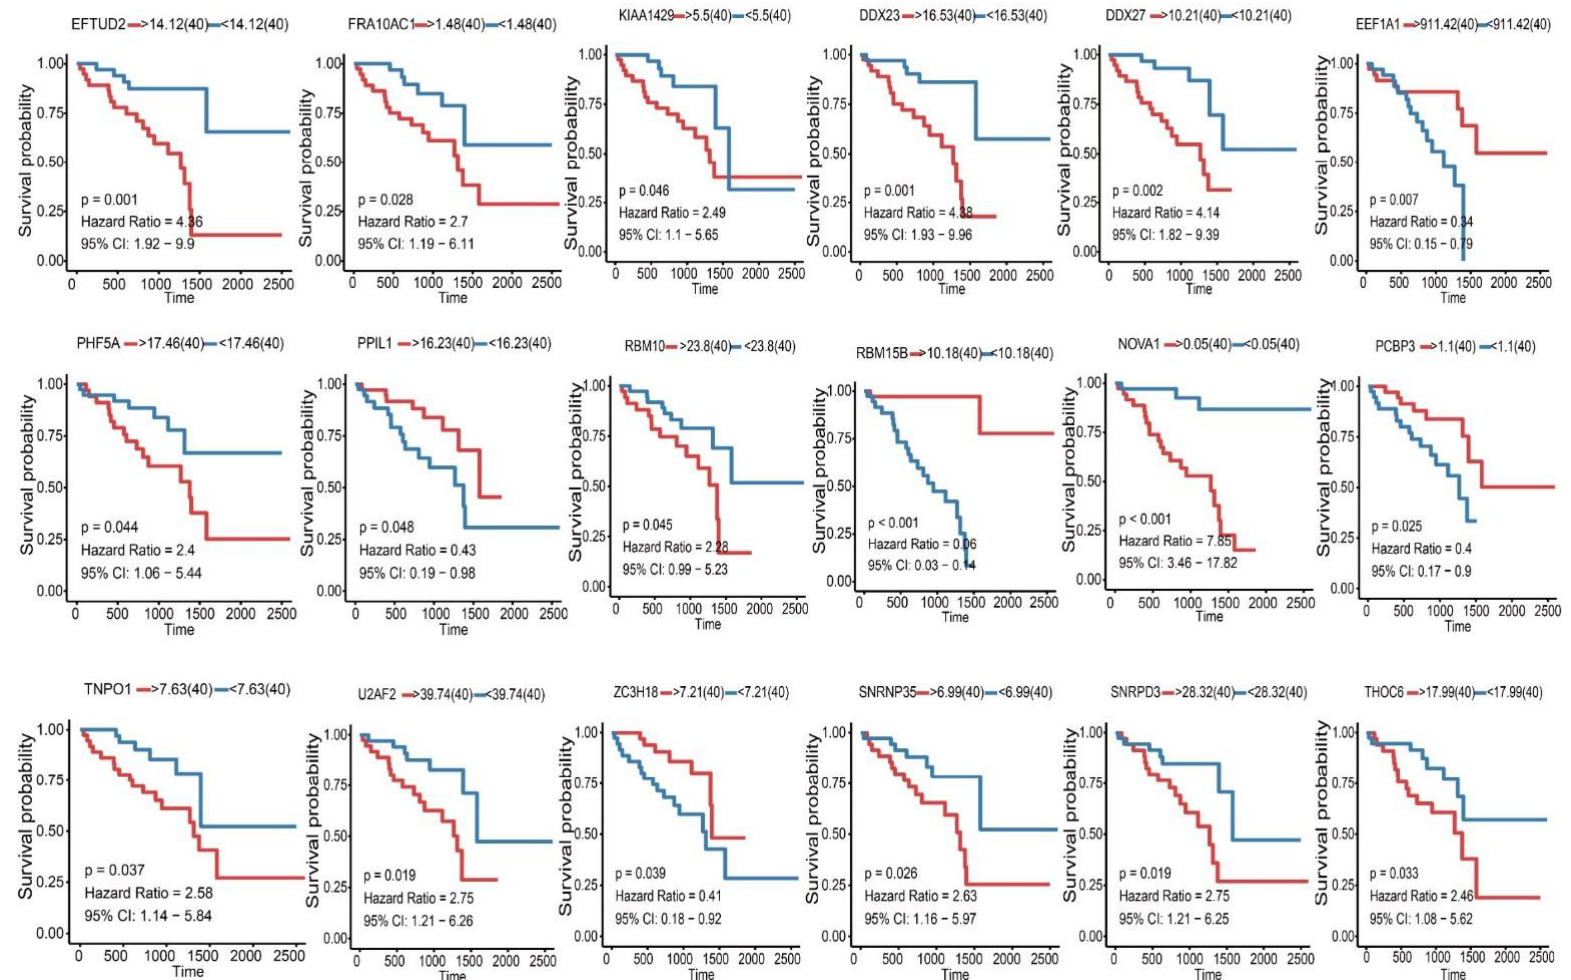
Figure 8. Kaplan-Meier survival analysis for 18 survival-associated splicing factor genes of UM. Their expression levels were classified into two groups by median value. Blue, low‑level group; red, high‑level group.